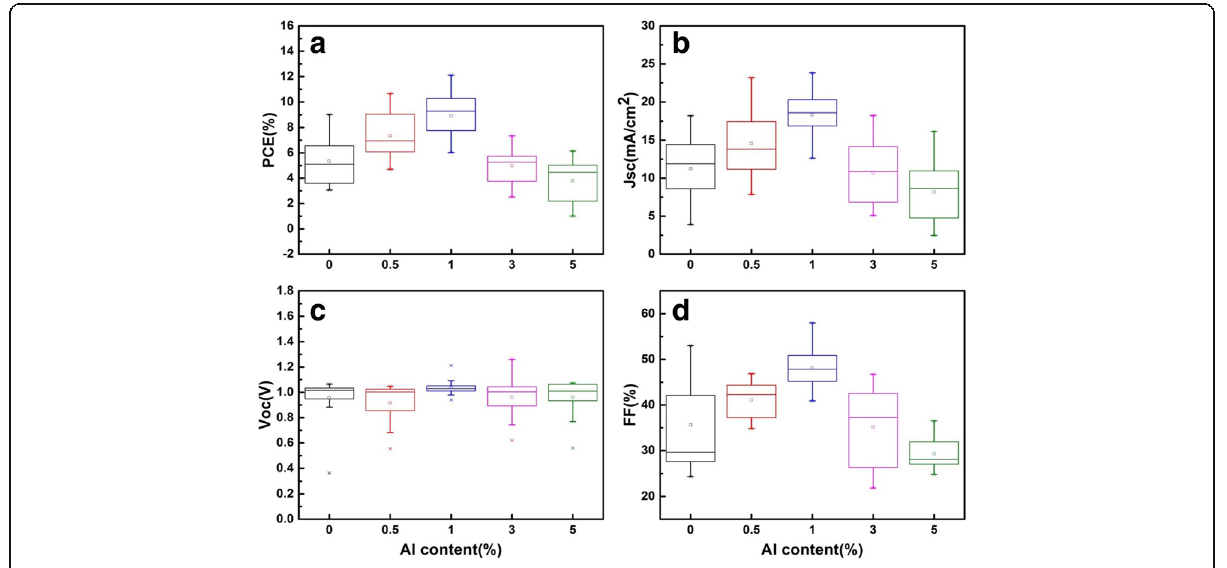
Fig. 4 Histograms of the different Al content on photovoltaic parameters including a PCE, b J SC , c V OC , and d